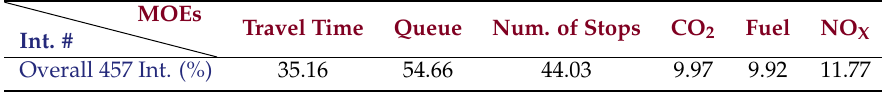
Table 9. Average (%) improvements of MOEs using DNB controller over PSC controller (100% Demand), over the links that are directly associated with intersections.